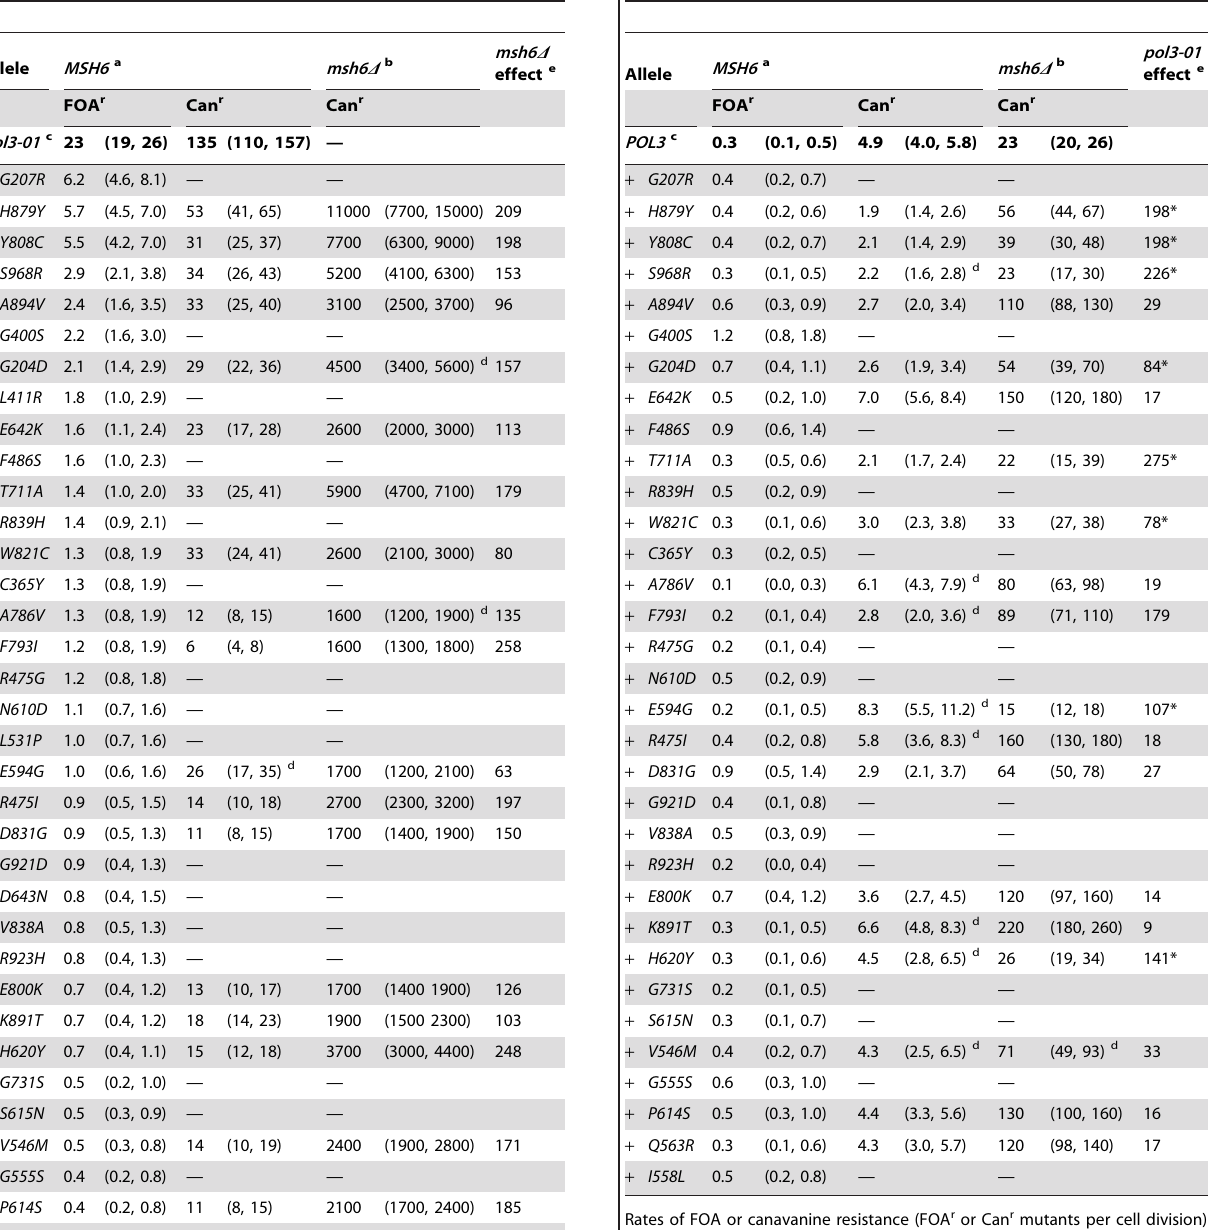
Table 1. Mutation Rates ( 6 10 2 7 ) of pol3-01,eex Mutant Strains. Table 2. Mutation Rates ( 6 10 2 7 ) of pol3-eex Mutant